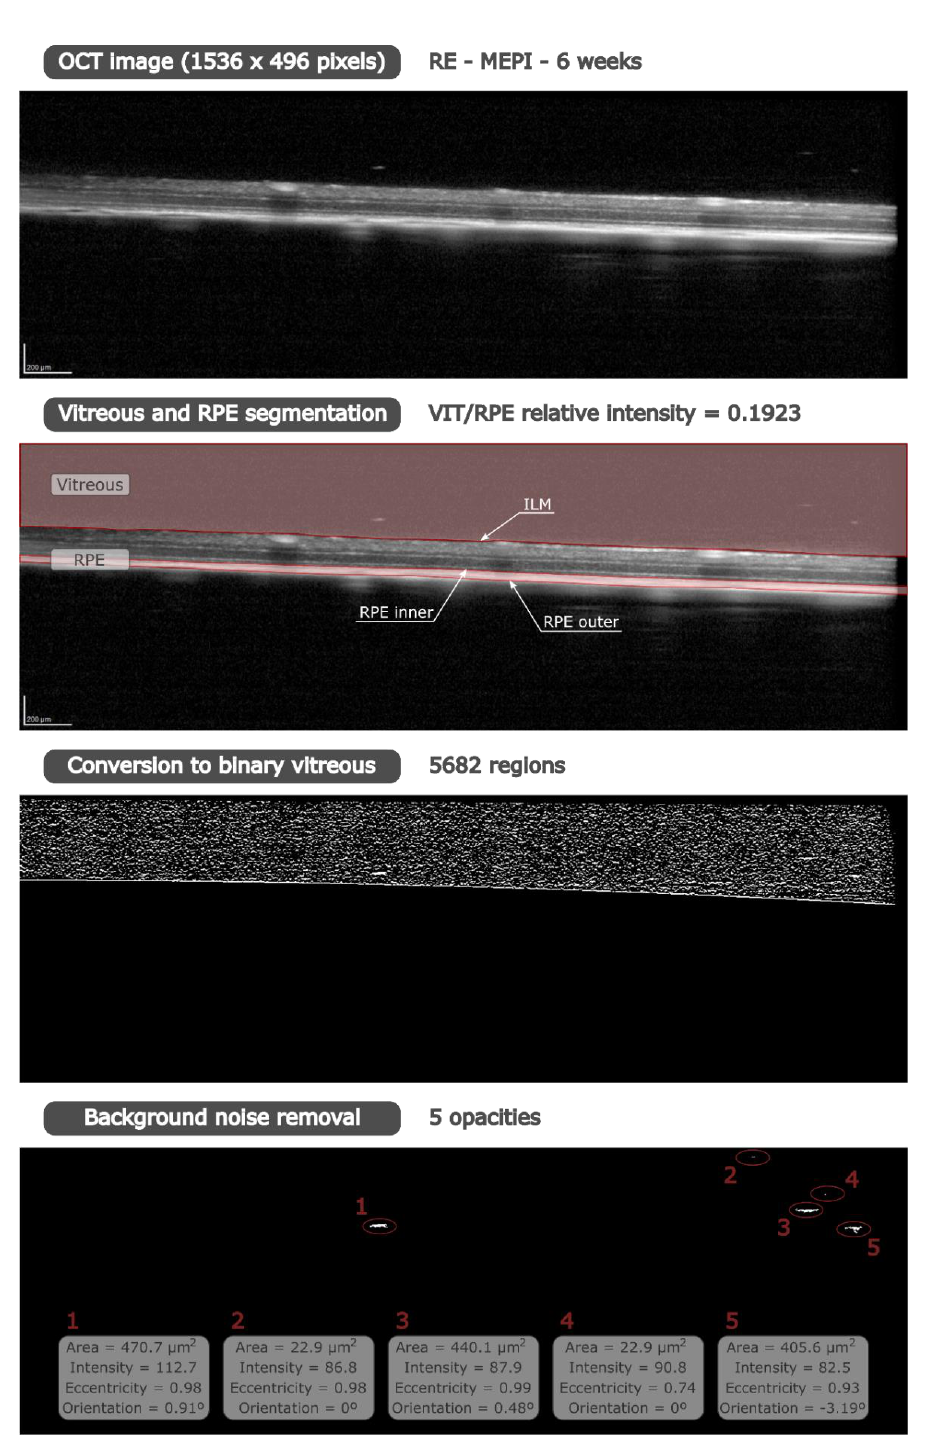
Figure 1. Methodology of the custom program implemented in Matlab (version R218a, Mathworks Inc., Natick, MA, USA). From an OCT (HR-OCT Spectralis, Heidelberg ® Engineering, Heidelberg, Germany) image of a right eye with the MEPI model at 6 weeks, VIT/RPE relative intensity was quantified after vitreous and RPE segmentation. To analyse the opacities/cells, it is necessary to remove the background noise of the vitreous. Our denoising filter was applied to the grey scale image intensity in those regions identified in the binary image. Therefore, intensity was obtained from the grey scale image, while area, eccentricity and orientation were computed from the binary image. Abbreviations: OCT: optical coherence tomography; RE: right eye; MEPI: glaucoma model induced by sclerosing the episcleral veins; VIT: vitreous; RPE: retinal pigment